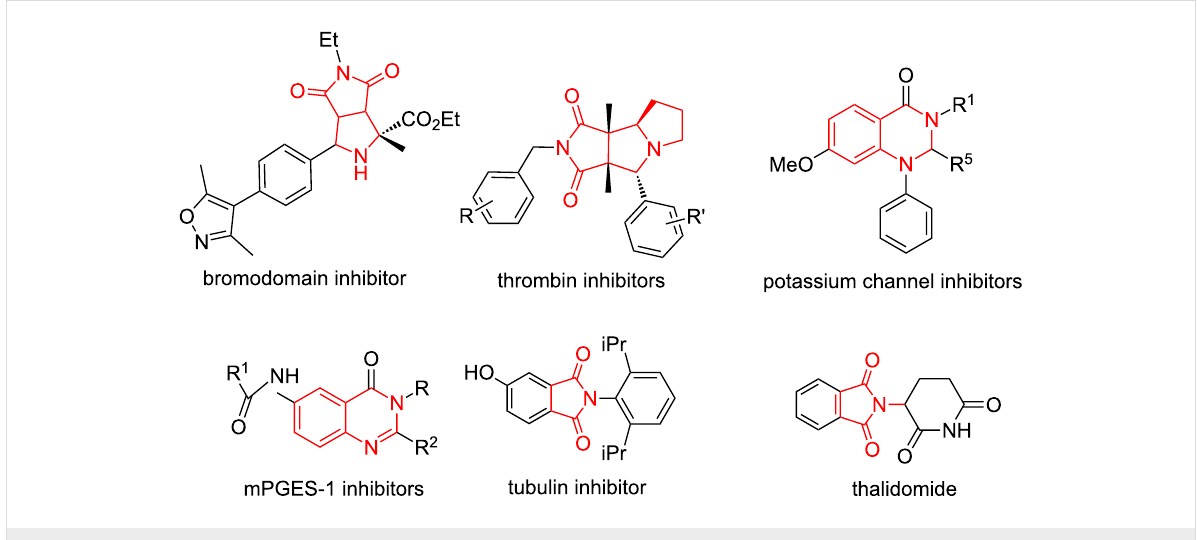
Figure 1: Heterocyclic fragments in bioactive compounds.